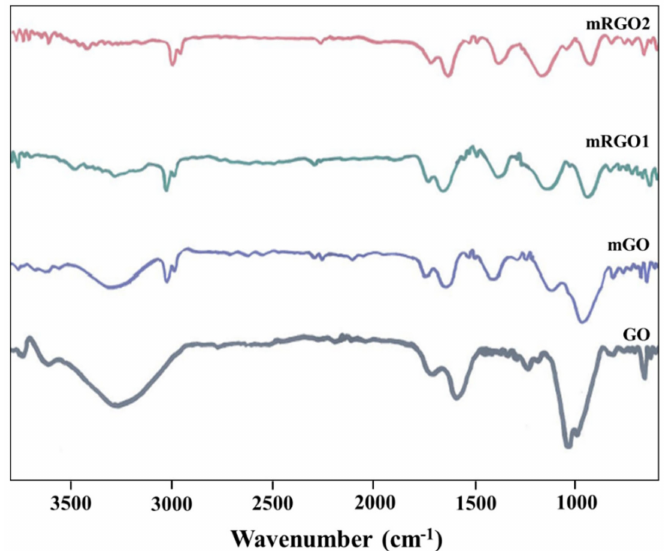
Figure1. Fouriertransforminfrared(FT-IR)spectroscopyspectraofgrapheneoxide(GO),polymerizable modified GO (mGO), chemical (mRGO1) and solvothermal (mRGO2) reduction